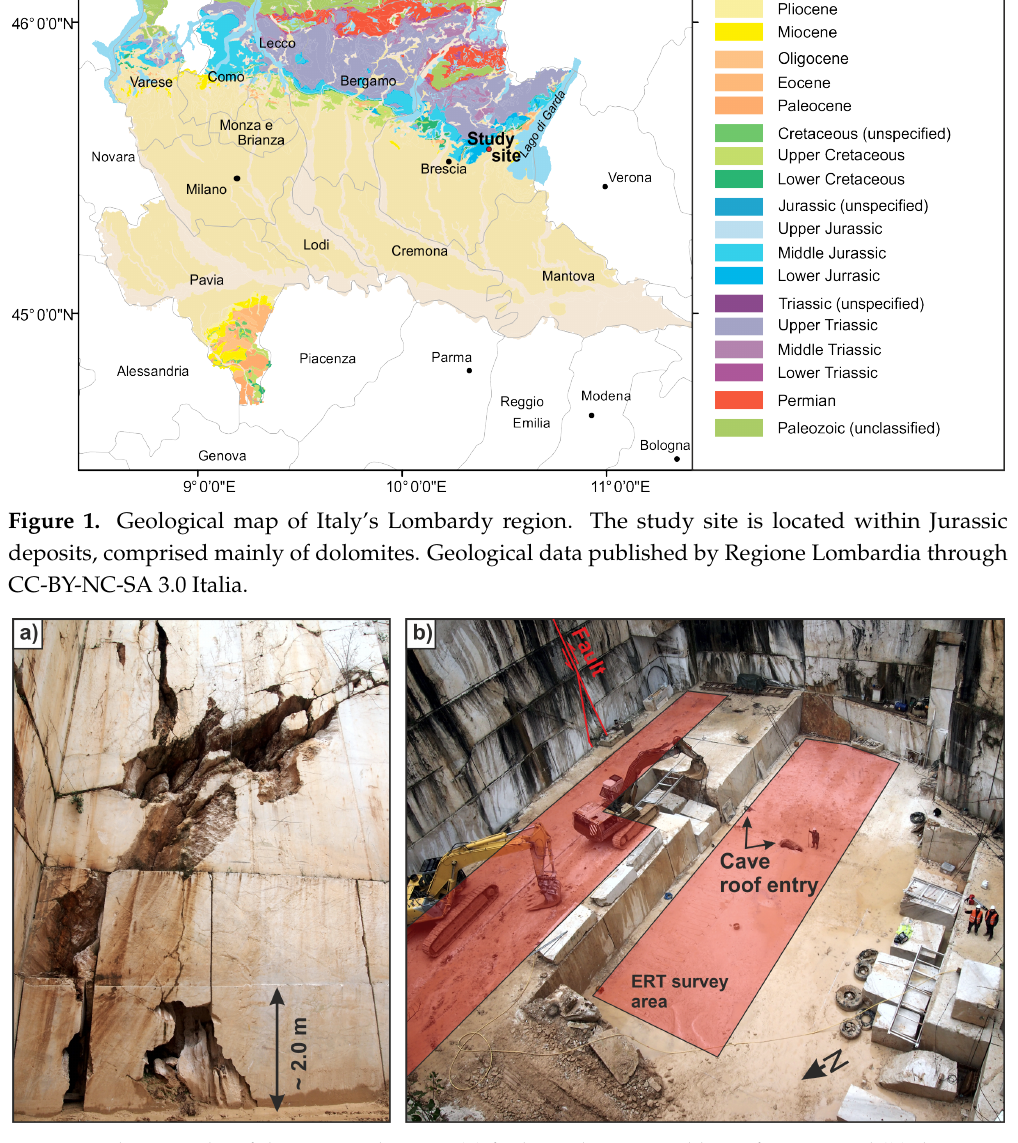
Figure 2. Photographs of the quarry showing ( a ) faults and associated karstification, and ( b ) the active extraction area, including the electrical resistivity tomography (ERT) survey area and entrances to the cave that were observed from the